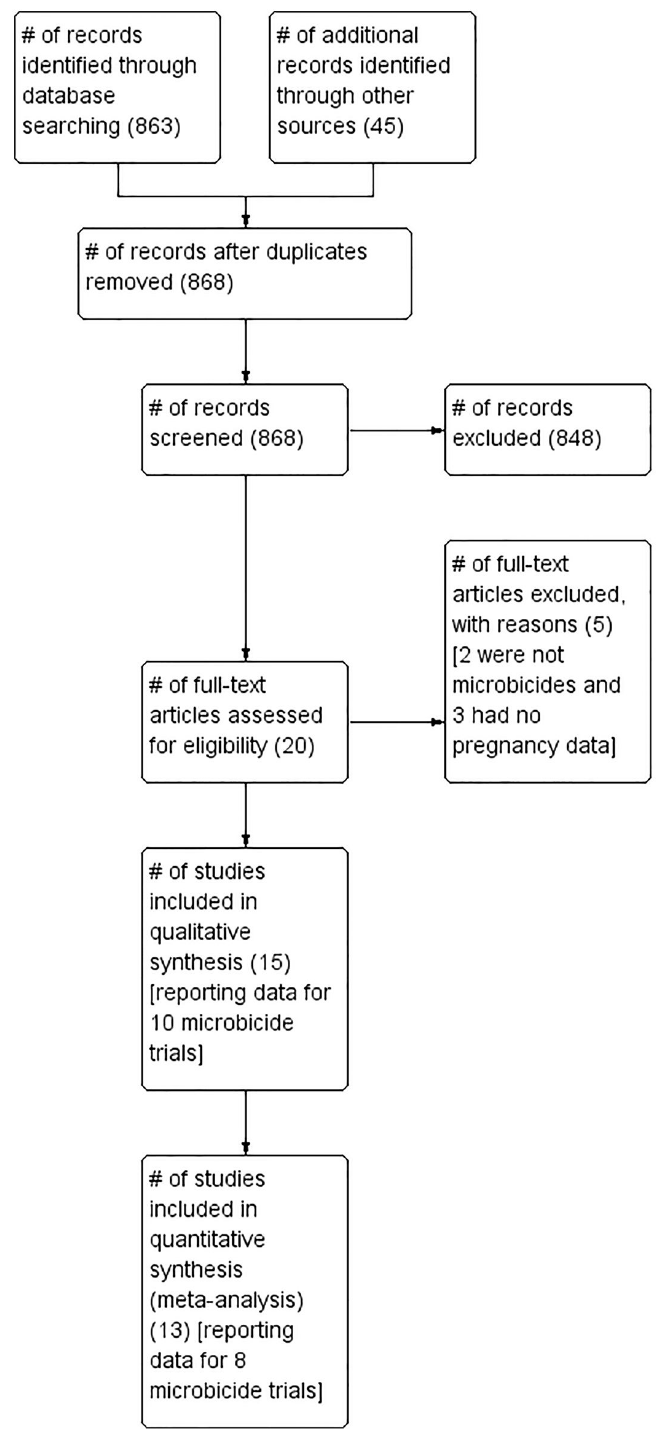
Figure 1. Study flow